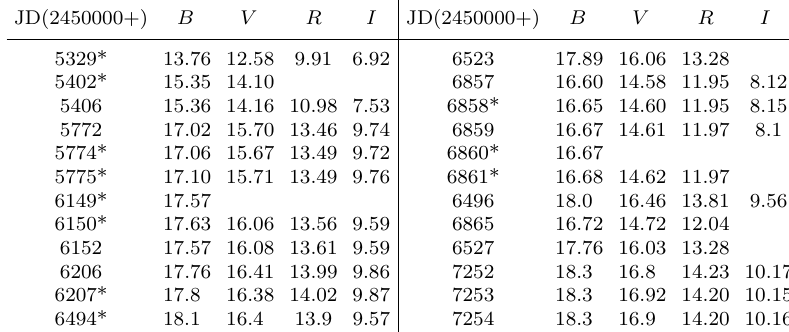
Table 3. BV RI photometry of V407 Cyg (the dates when we attempted to detect (cid:13)ickering are marked with asterisks). JD(2450000+) B V R I